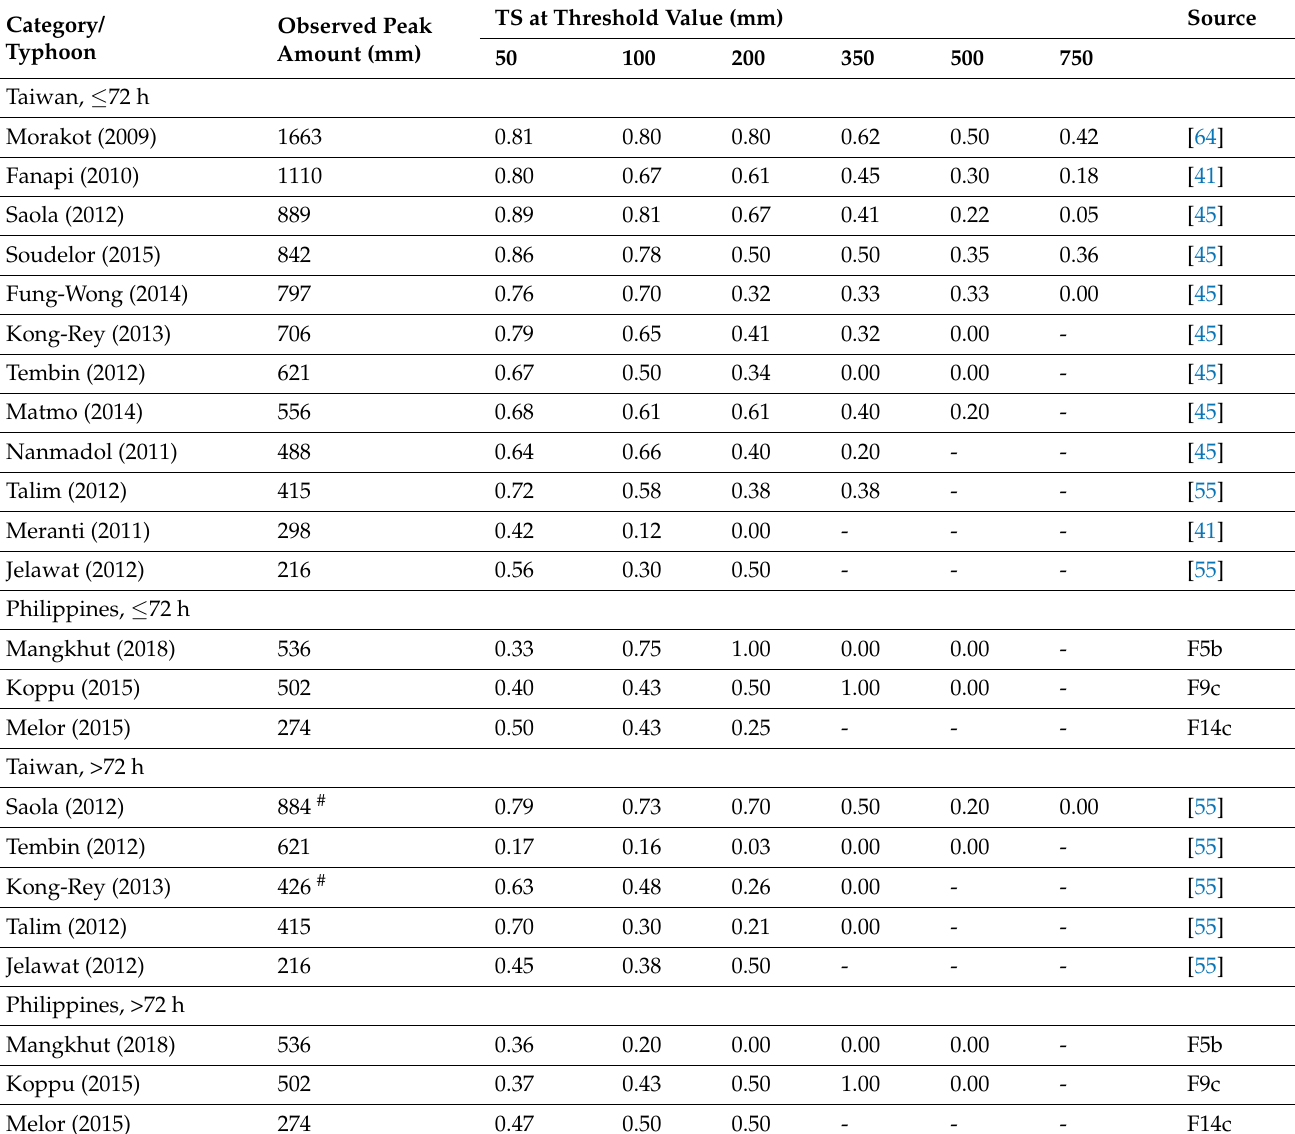
Table 3. Comparison of TS values of 24 h QPFs by the CReSS model between selected typhoons in Taiwan and the three TCs in the Philippines in this work, at six rainfall thresholds from 50 to 750 mm. Results are grouped into those within the short range (when the target period is inside 72 h from t 0 , top half) or beyond (>72 h, bottom half), and sorted by the observed peak rainfall amount (mm) from high to low. For each typhoon, the best TS values are listed from all available runs in the ensemble (if applicable). A “-” indicates threshold exceeding the peak amount, and the letter “F” in the source column represents a figure in this